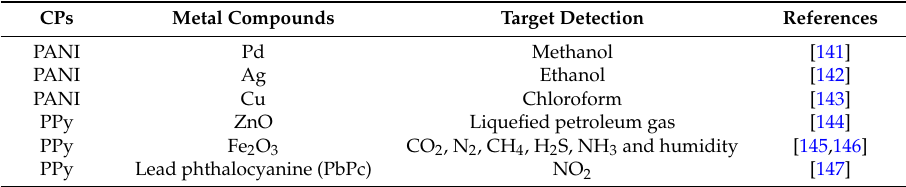
Table 5. Metal or metal compound/CP nanocomposites for chemical